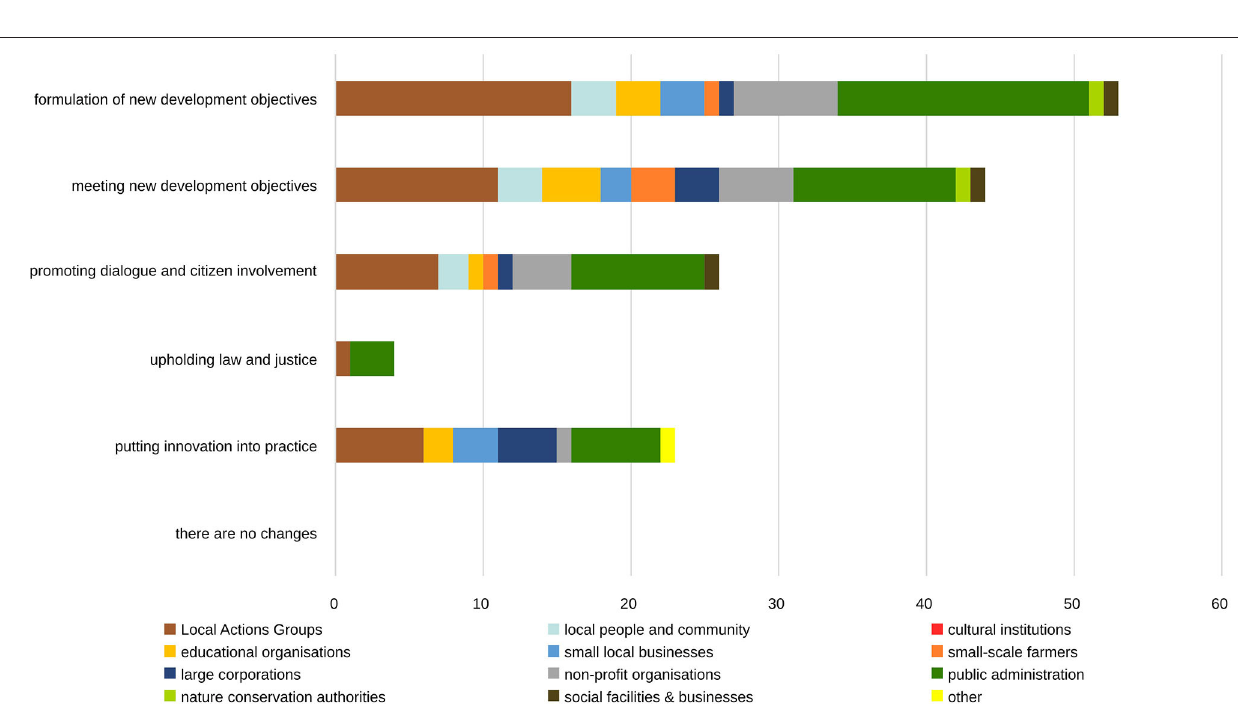
FIGURE 4 | Which actors are involved in changes toward sustainability, n = 45. Answers to the open-ended question: Which actors are at the PRESENT TIME helping to START a discussion on sustainability in your LAG on the following topics? Actors mentioned by the respondents in open ended responses were consequently assigned into the categories of actors developed through theoretically-based